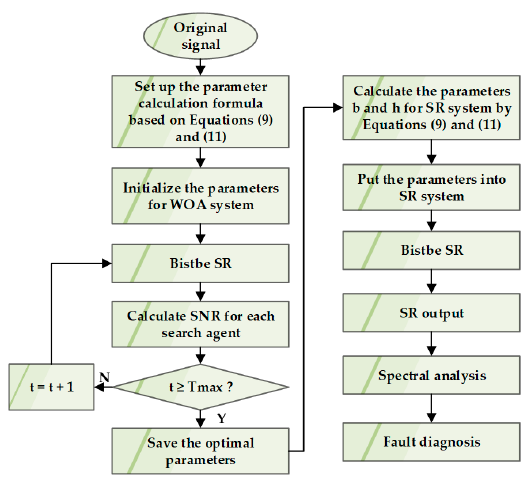
Figure 4. SR fault diagnosis flowchart based on